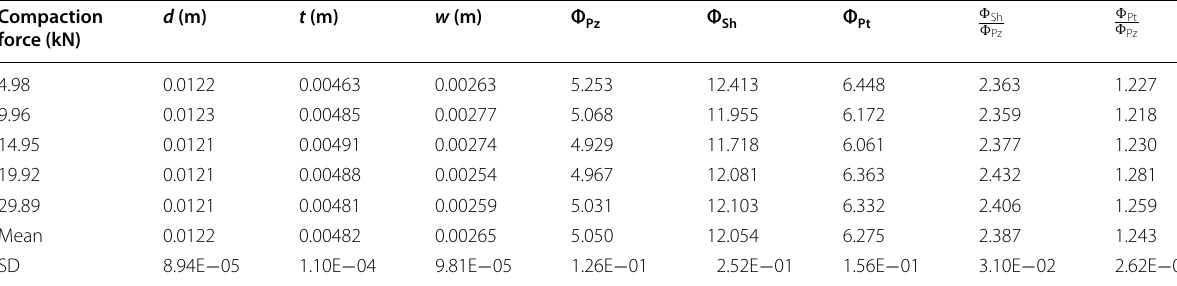
Φ PZ , Φ Sh , Φ Pt : Shape factors according to Podczeck et al. (2013), Shang et al. (2013), Pitt and Heasley (2013), respectively. d diameter, t axial tablet thickness, central cylinder thickness, SD standard deviation